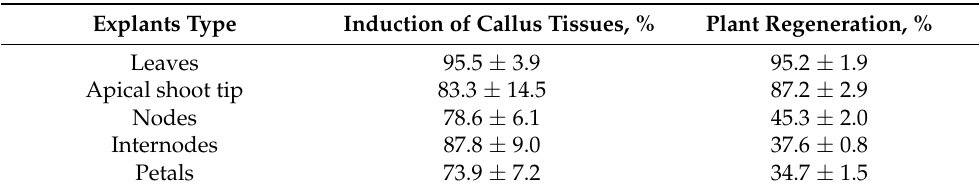
Table 2. The callus induction and plant regeneration capacities of calli from different types of explants of Paulownia tomentosa on MS2